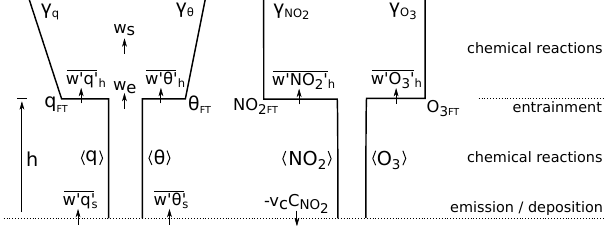
Fig. 1. Conceptual representation of the vertical profiles of specific humidity ( q ), potential temperature ( θ ) and, as an example, nitro- gen dioxide (NO 2 ) and ozone (O 3 ). Within the mixed-layer all vari- ables are constant with height (Eq. 1), topped by an inversion de- fined as 1φ = φ FT −h φ i (Eq. 3). The processes that are relevant for chemistry are shown on the right side, with emissions and de- position near the surface, chemical reactions within the mixed-layer and free-troposphere, and entrainment of free-tropospheric air at the mixed-layer top ( w 0 φ 0 h , Eq.